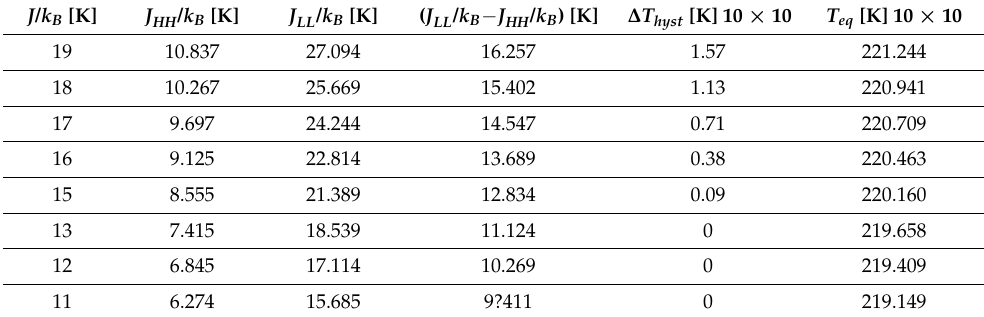
Figure 5. Thermal evolution of the HS fraction in a SCO system with a size of 10 × 10 for different values of the average interaction parameter J / k B : J / k B = 19 K (magenta square), J / k B = 18 K (dark yellow square), J / k B = 17 K (red square), J / k B = 16 K (purple square), J / k B = 15 K (black square), J / k B = 13 K (green square), J / k B = 12 K (orange square), J / k B = 11 K (blue square). The computational parameters are: ∆ / k B = 1300 K, G / k B = 172.2 K, x = J HH / J LL = 0.4 and ln( g ) = 6.01. Table 2. Evolution of the thermal hysteresis width, ∆ T hyst = T up − T down , and the equilibrium temperature, T eq , as a function of J / k B , J HH / k B and J LL / k B in a SCO system with a size of 10 × 10. The computational parameters are: ∆ / k B = 1300 K, G / k B = 172.2 K, x = J HH / J LL and ln( g ) = 6.01.